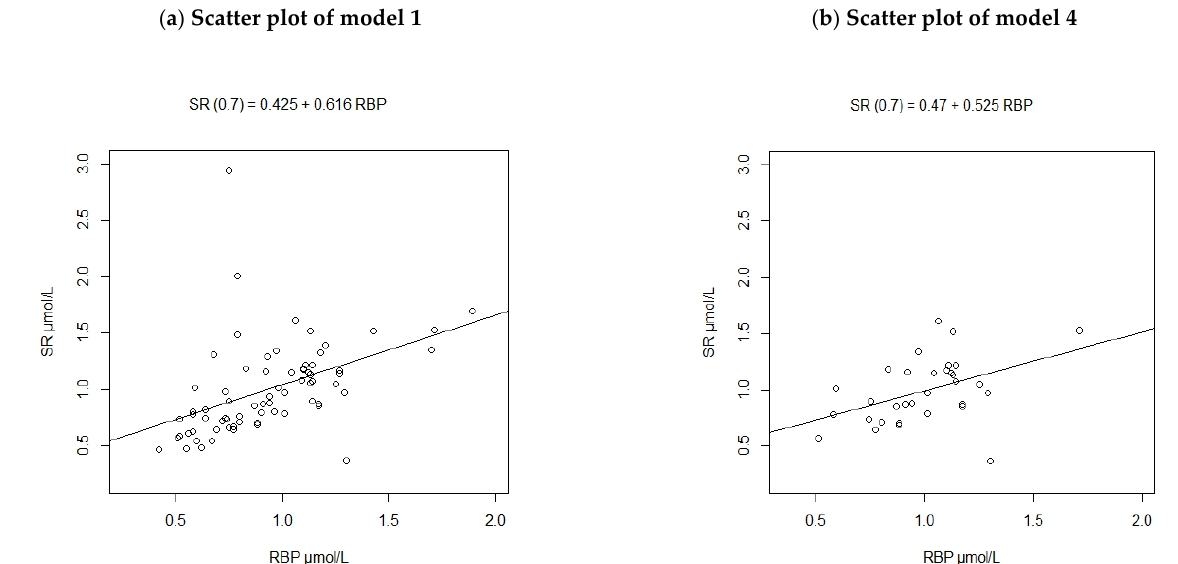
Figure 2. Scatterplots of Retinol Binding Protein against Serum Retinol concentrations from the sub-sample of pre-school children ( a ) before removing inflamed participants (n = 72), ( b ) after removing inflamed participants (n = 32). Table 3. Model outputs of the linear regression and correlation coefficients before and after correcting for